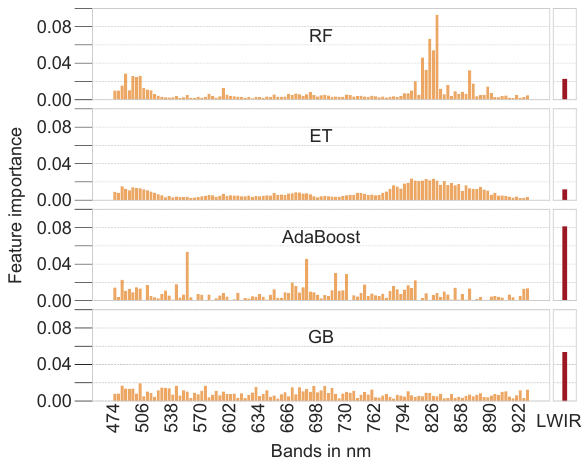
Figure 5. Feature importance of the RF regressor, the ET regres- sor, the AdaBoost regressor, and the GB